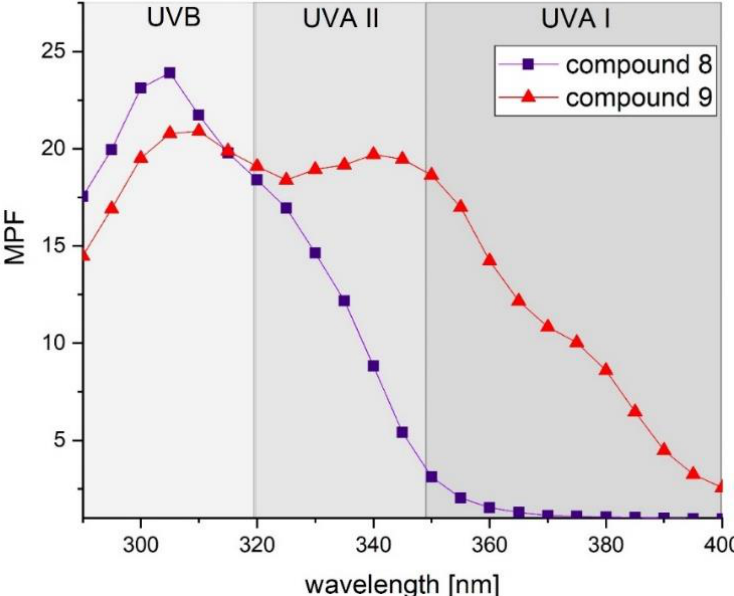
Figure 5. UV absorption spectra of compounds 8 and 9 obtained in cosmetic formulation at 12.5% ( w / w ) cosmetic formulation applied on polymethylmethacrylate plates. MPF—monochromatic protection factor.